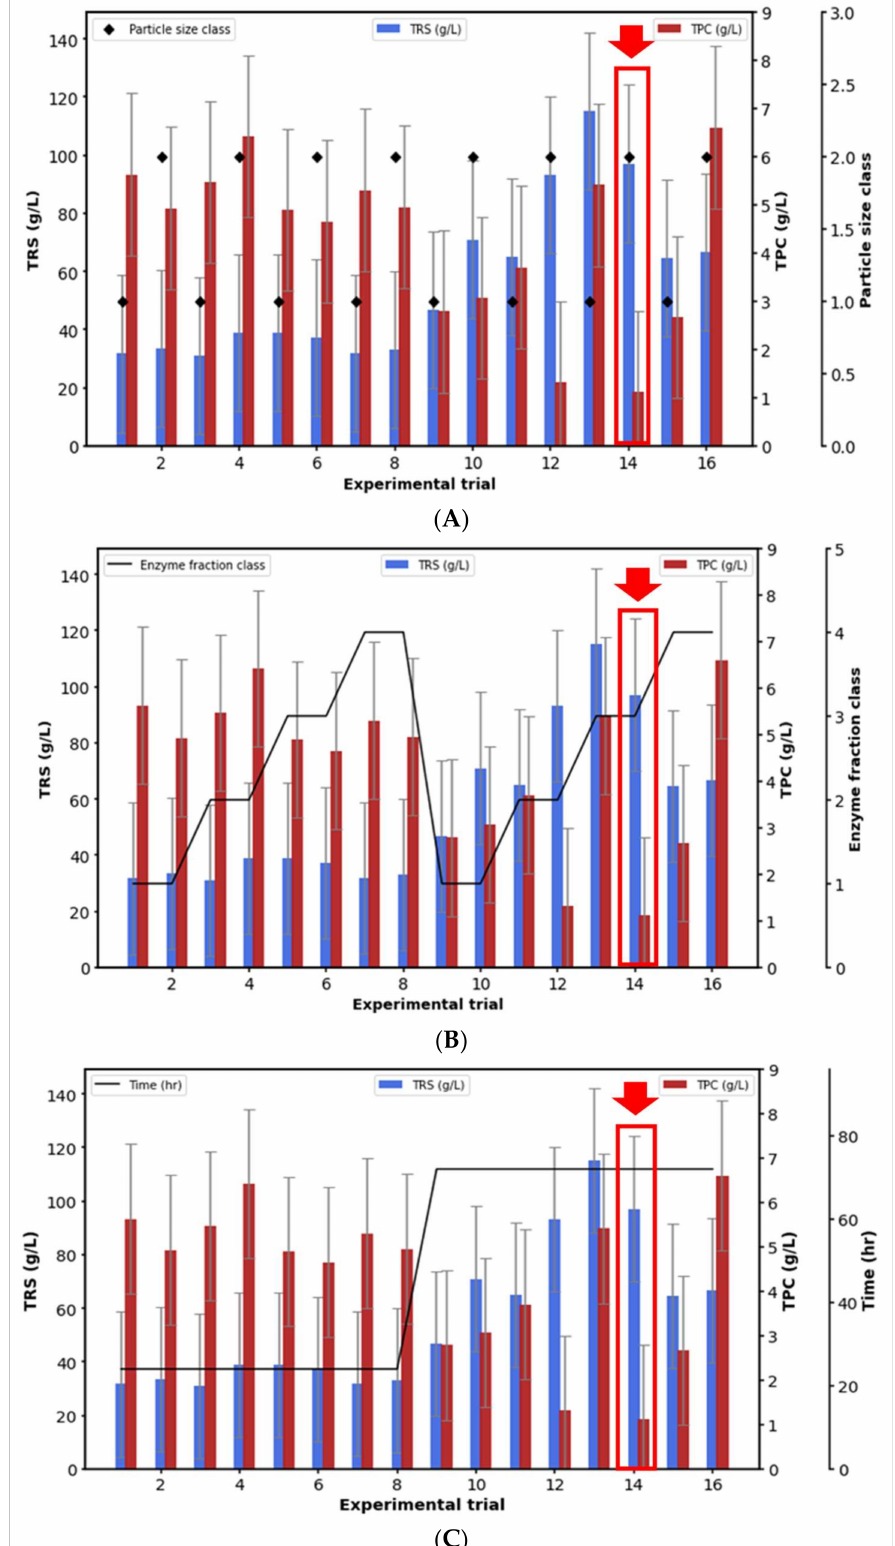
Figure 1. Variation of TRS and TPC production with ( A ) particle size, ( B ) enzyme fraction, and ( C )